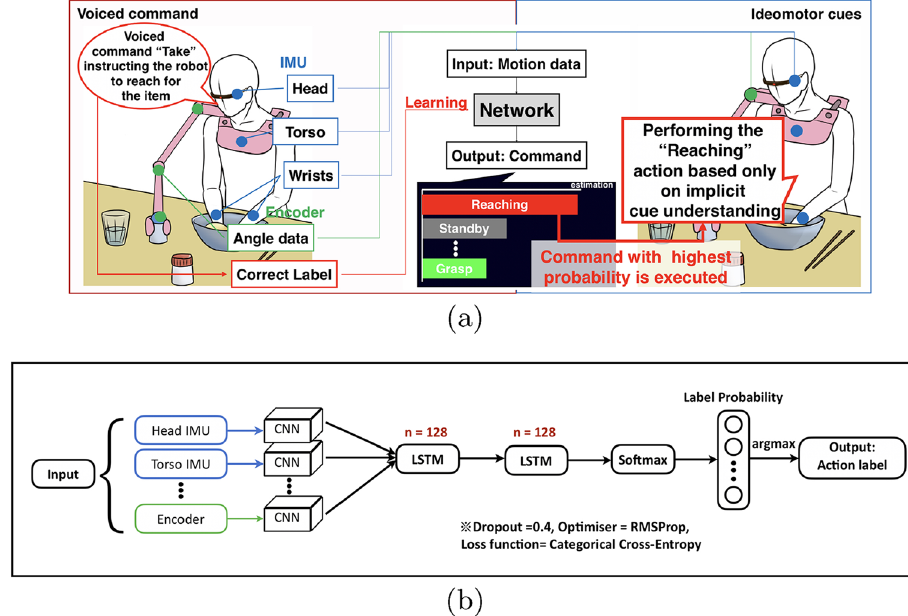
Fig. 10 Concept and Network Representation. a Overall flow with use case example. b Detail of the network